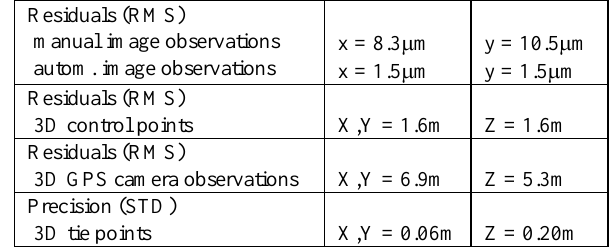
Table 1: Results from final AT of image block The basic results i.e. residuals of observations and precision of